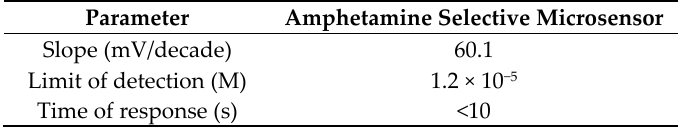
Table 1. Characteristic response of the amphetamine selective microsensor.